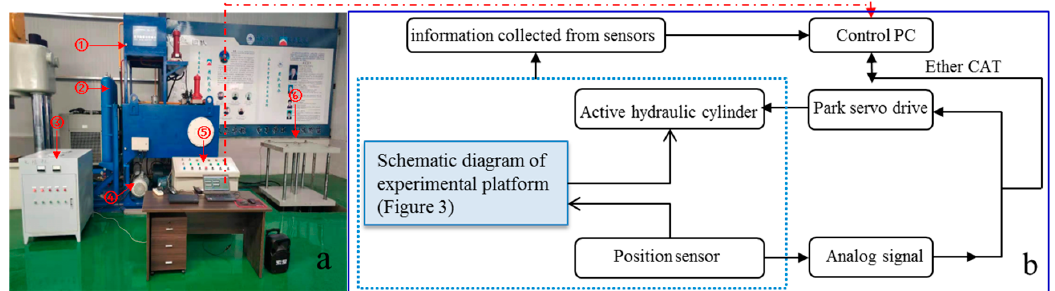
Figure 6. Wave power experiment device and experimental principle. ( a ) Wave power experimental device, ( b ) block diagram of the experimental setup.